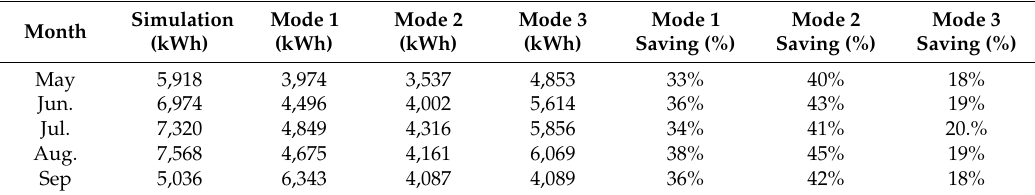
Table 6. Monthly energy consumption under the continuous and different modes of AC operation for House 2 during the summer.